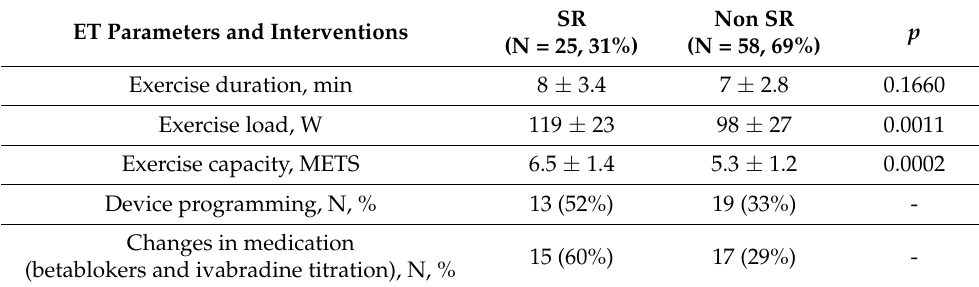
Table 4. Exercise test main parameters and interventions for device and medication optimization. ET Parameters and Interventions